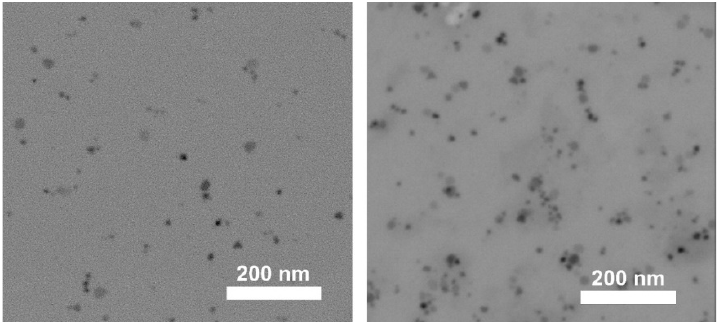
Figure 4. STEM (scanning transmission electron microscopy) pictures of Fe 3 O 4 nanoparticles deposited on a holey carbon film.